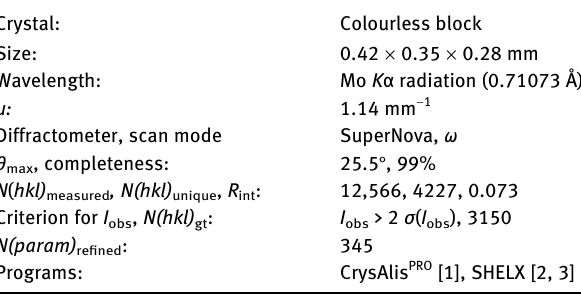
Table  : Data collection and